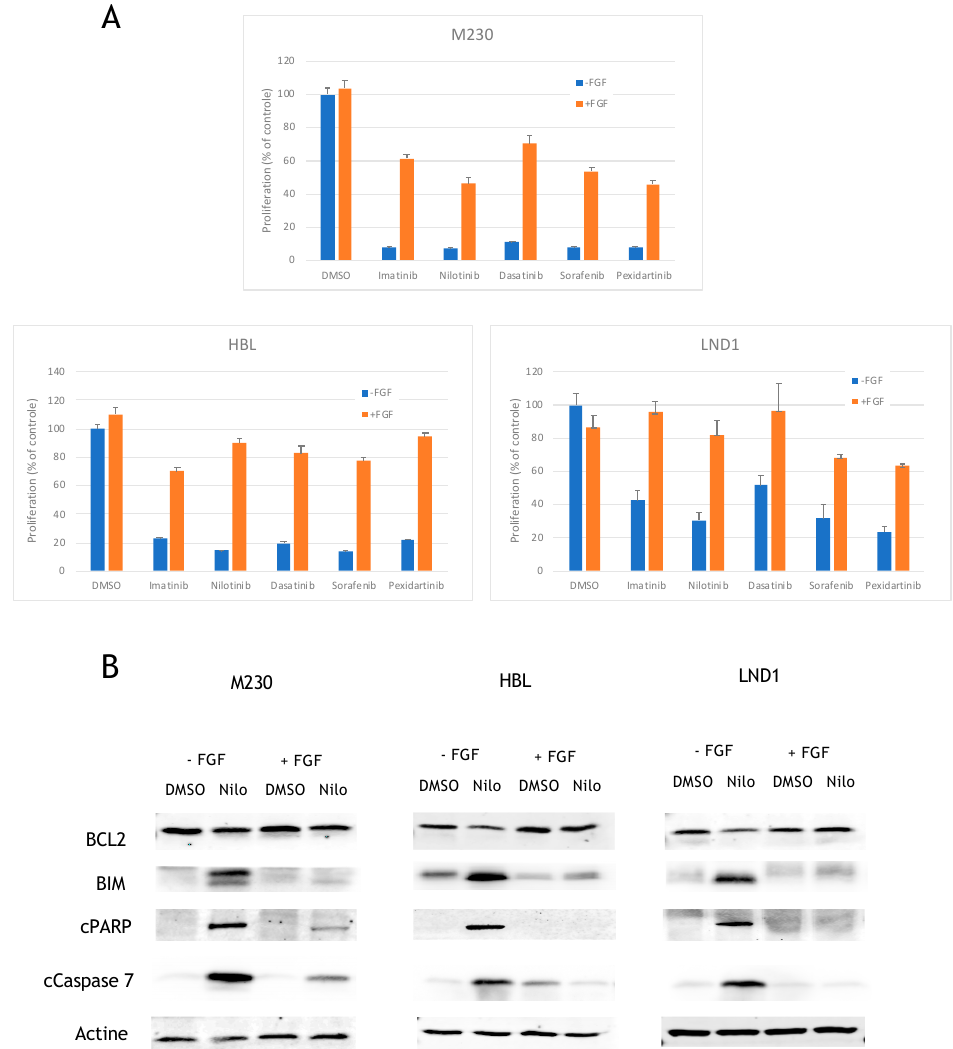
Figure 3. Effects of FGF2 on proliferation and signaling. ( A ) Cells were treated with DMSO or 1 µM of inhibitors in the absence or in the presence of 20 ng/mL FGF2 and proliferation was analyzed after 3 days (data are represented as mean +/ − SD). The effect of all KIT inhibitors was significantly reduced in all three cell lines in the presence of FGF2 (M230, p < 0.002; HBL, p < 0.01; LND1, p < 0.02; unpaired t -test). ( B ) Cells were treated for 24 h with DMSO or 1 µM nilotinib in the absence or in the presence of 20 ng/mL FGF2 and the levels of cleaved proteins (cPARP and cCaspase 7) or total protein were analyzed by Western blotting.